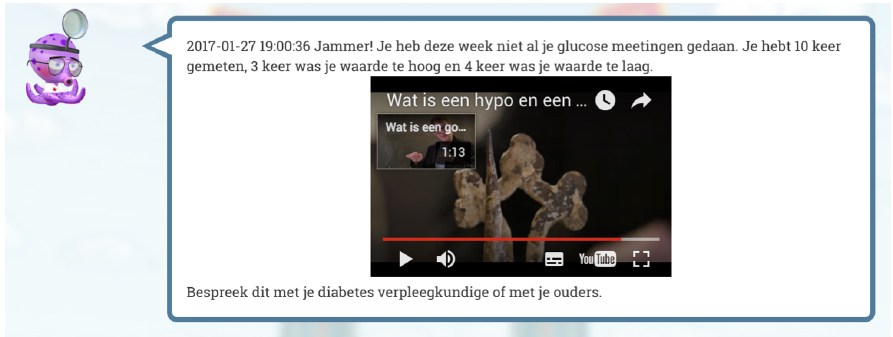
Figure 9. Example of a coaching message on the PERGAMON website. The message is in Dutch (English: “Too bad! This week you did not do all your glucose measurements. You measured 10 times, 3 times your level was too high and 4 times your level was too low. Please, discuss this with your diabetes nurse or with your parents.”